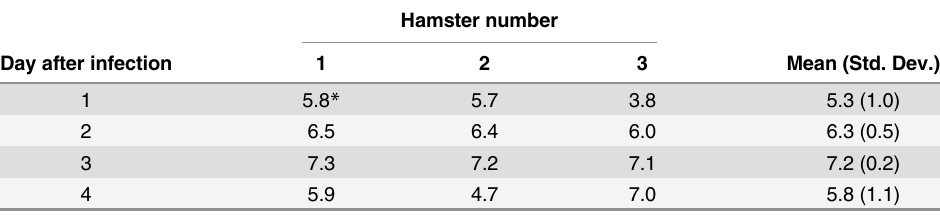
Table 3. Replication of El Huayo virus in Syrian